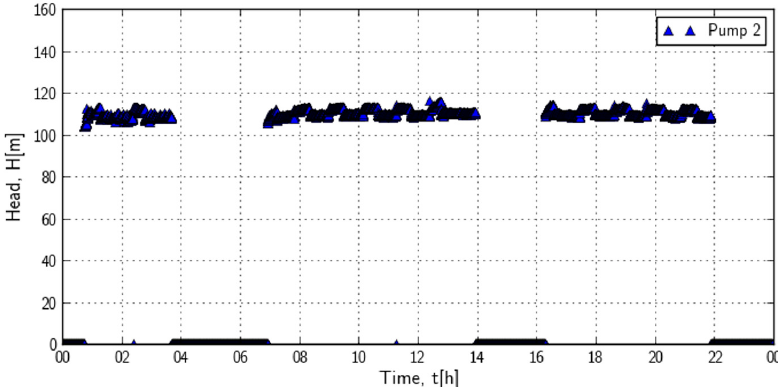
Figure 8. The PU2 head change diagram H(t) on 30 December 2009.